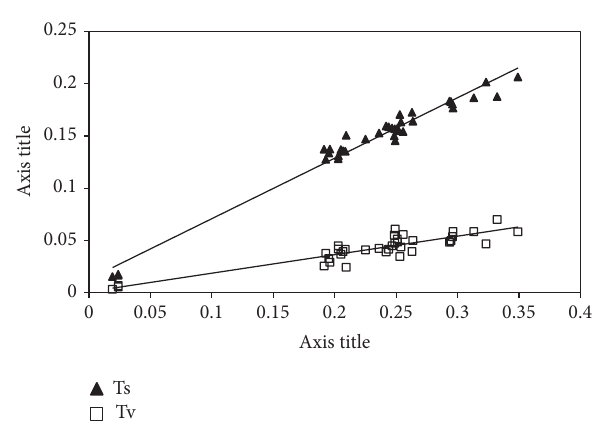
Figure 3: Bayesian tree inferred from complete CR sequences. Posterior probability values (%) are indicated close to the nodes of the branches.